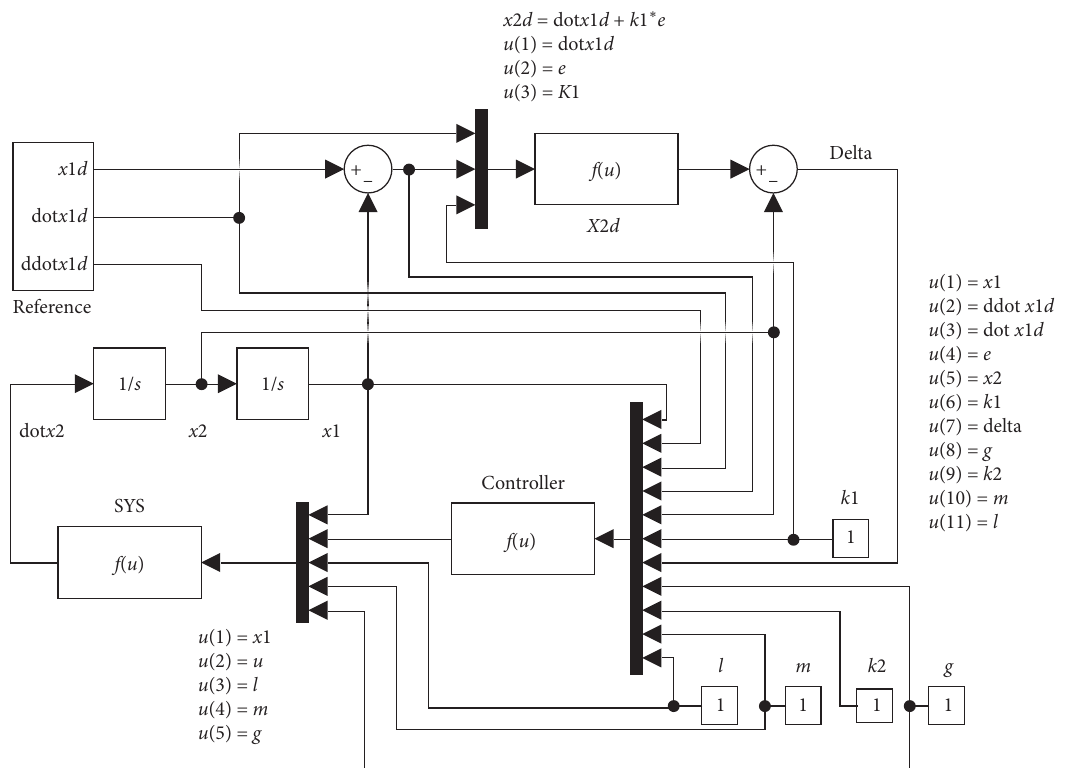
Figure 3: Schematic for backstepping algorithm by using Matlab @